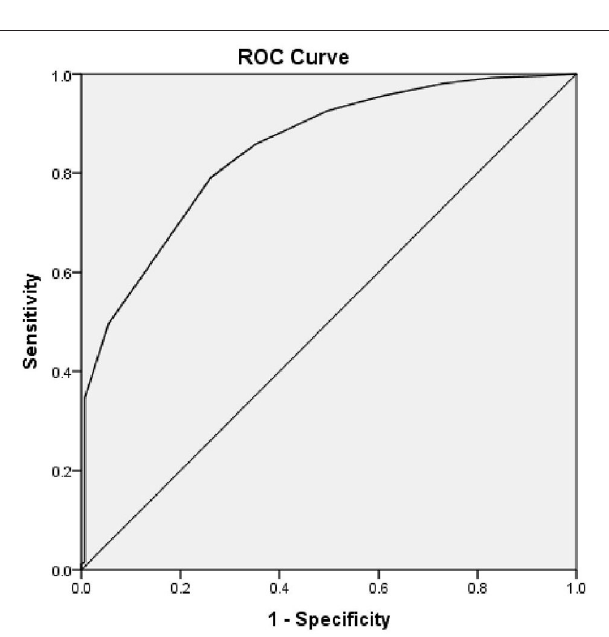
FIGURE 3 | ROC curve—duration of diabetes with cognitive impairment.